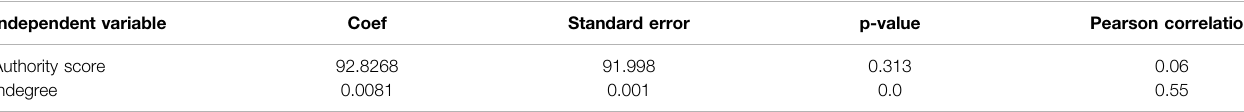
TABLE 3 | Relationship between importance and indegree/authority in United Kingdom cases. N (cid:1) 280 . Coef fi cients and standard errors calculated using logit. The dependant variable is whether the case was reported in The Law Reports . Independent variable